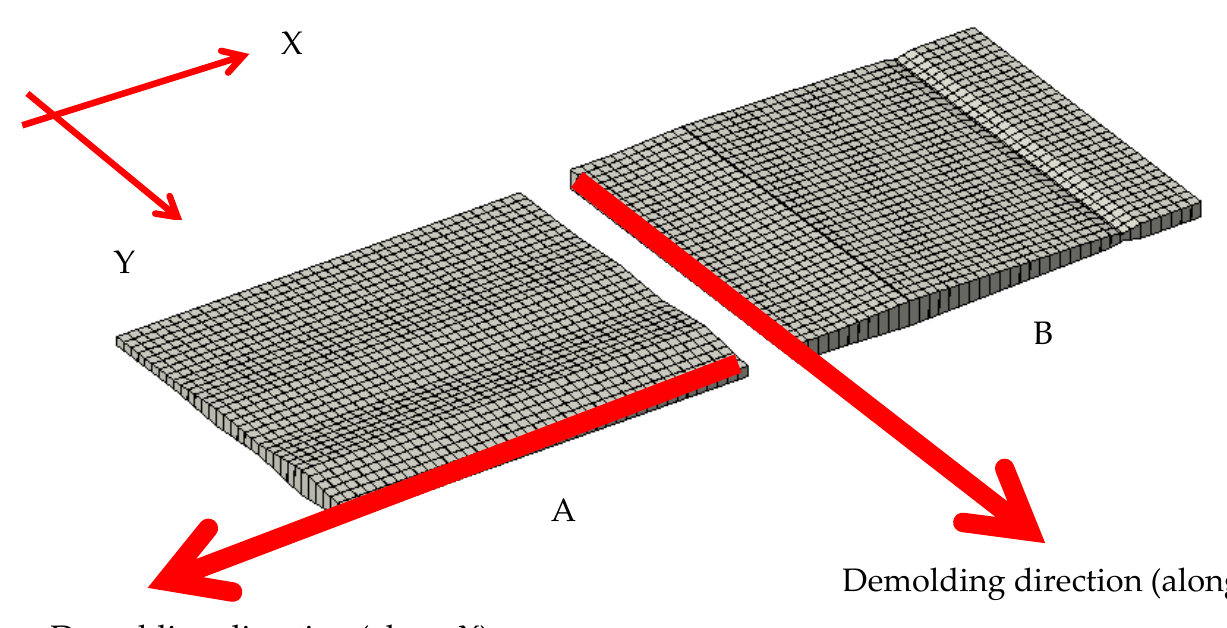
Figure 4. Thickness-variation constraint.